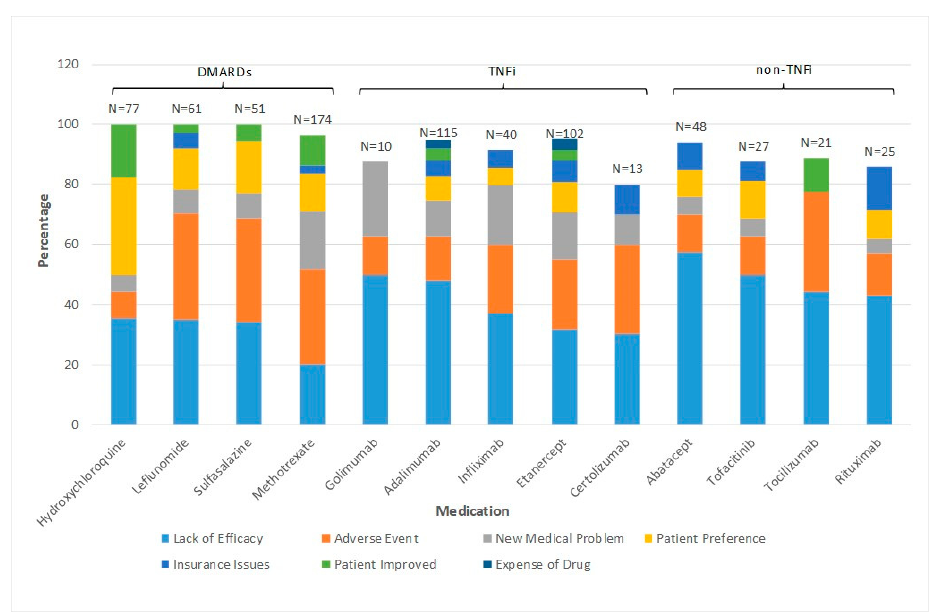
Figure 1. Results of reasons why RA patients change biologic or small molecule therapy within one academic practice in the US between 2008 and 2016.